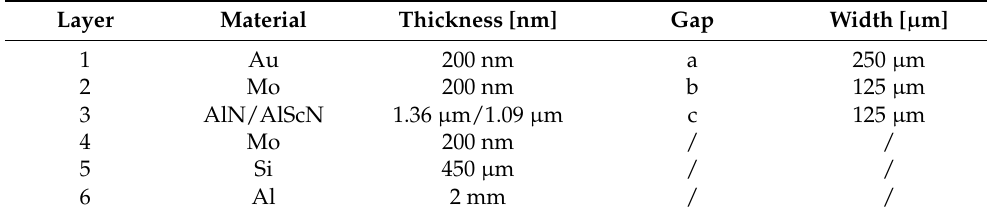
Table 2. Input parameters of the simulation model for the